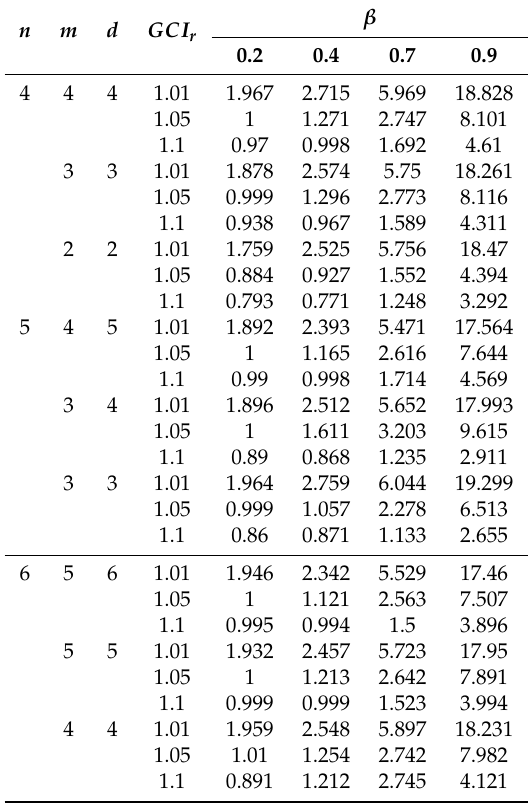
Table 3. Average values of iterations in Algorithm